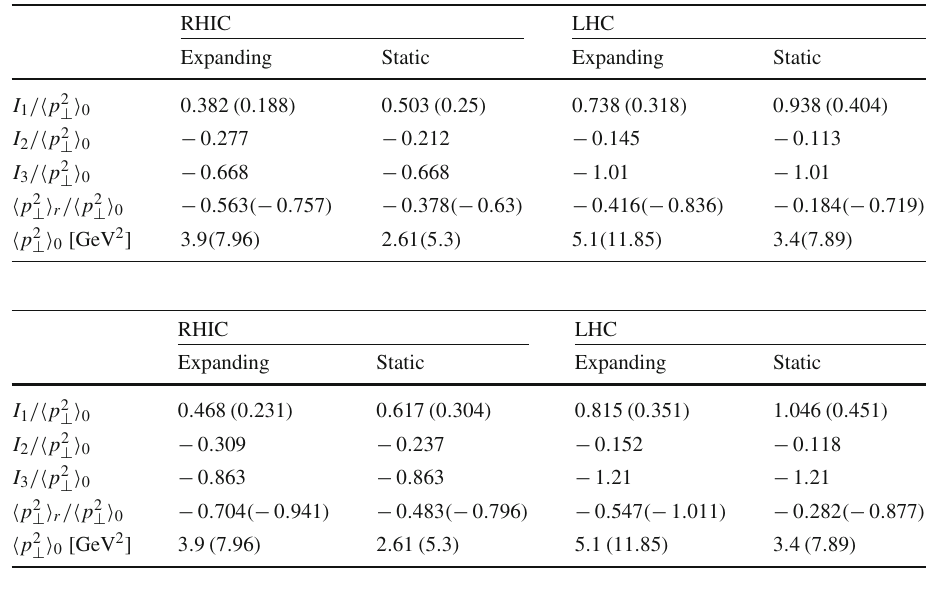
Table 1 The results for